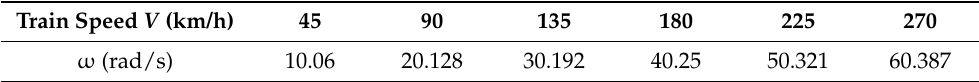
Table 4. Relationship between ω and different train